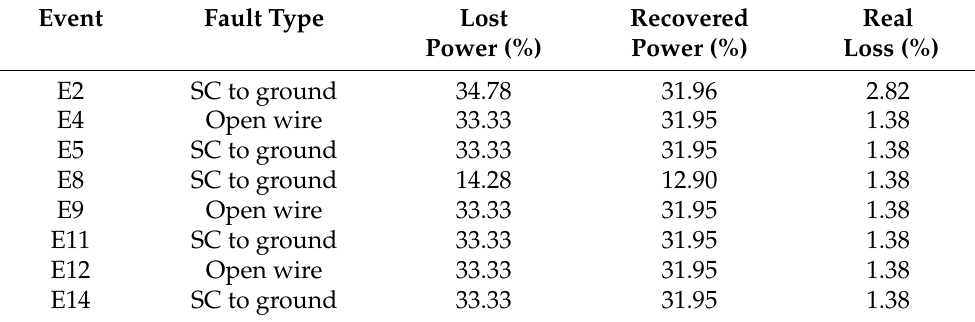
Table 6. Power loss and recovered power with the